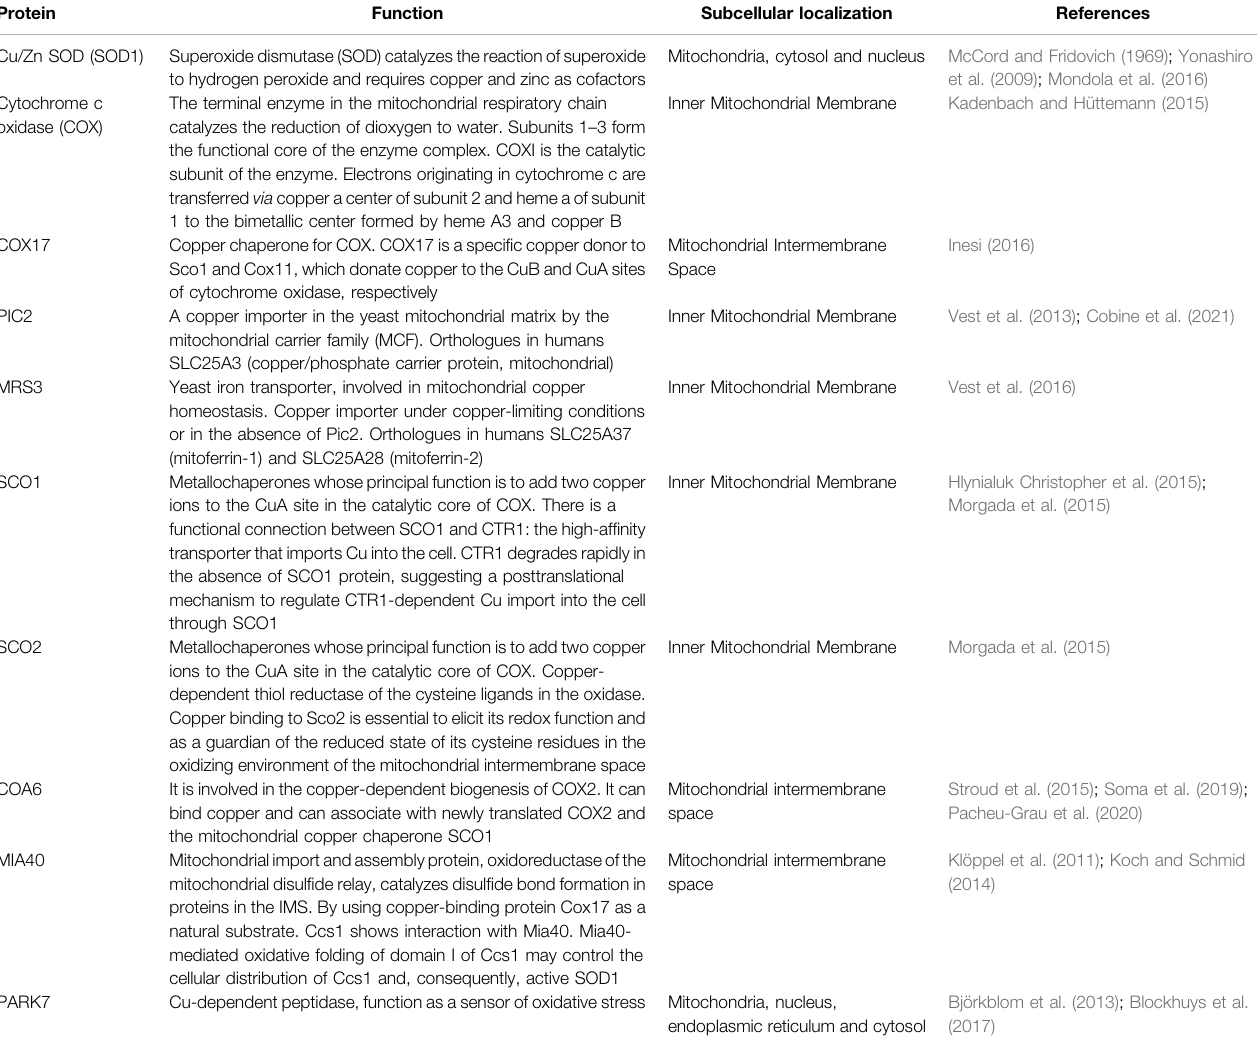
TABLE 1 | Copper binding and copper-dependent proteins key for the mitochondrial homeostasis. Protein Function Subcellular